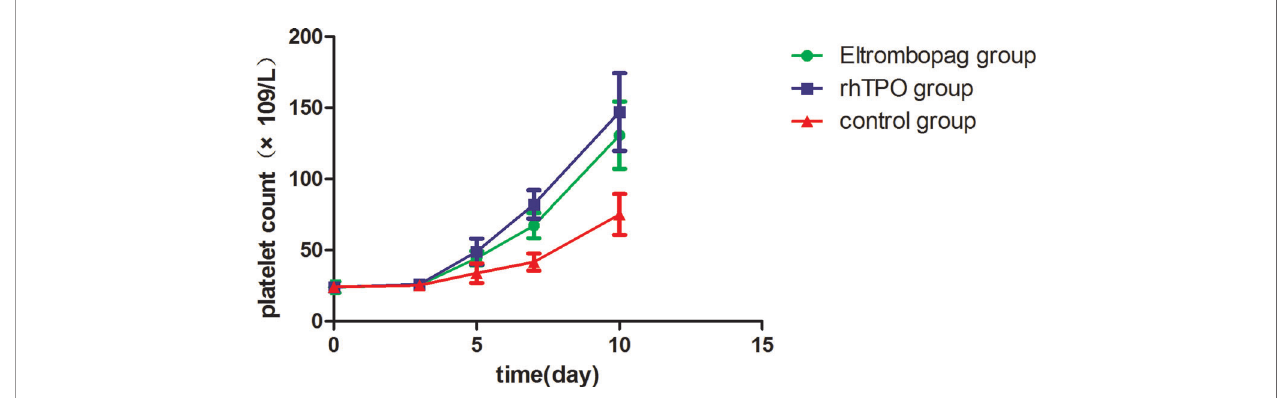
FIGURE 1 | Mean platelet counts during treatment period among the three groups. Error bars indicate 95% CI of the mean. CI, con fi dence interval.